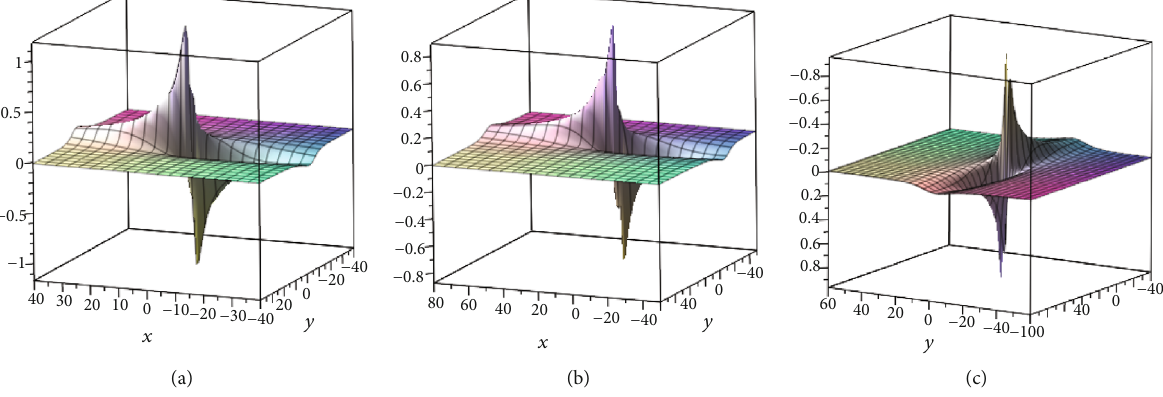
Figure 3: (Color online) soliton solution u with t = 0, 15, 30 : 3D